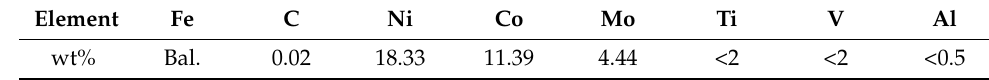
Table 1. Chemical composition of the maraging tool steel Specialis ® .